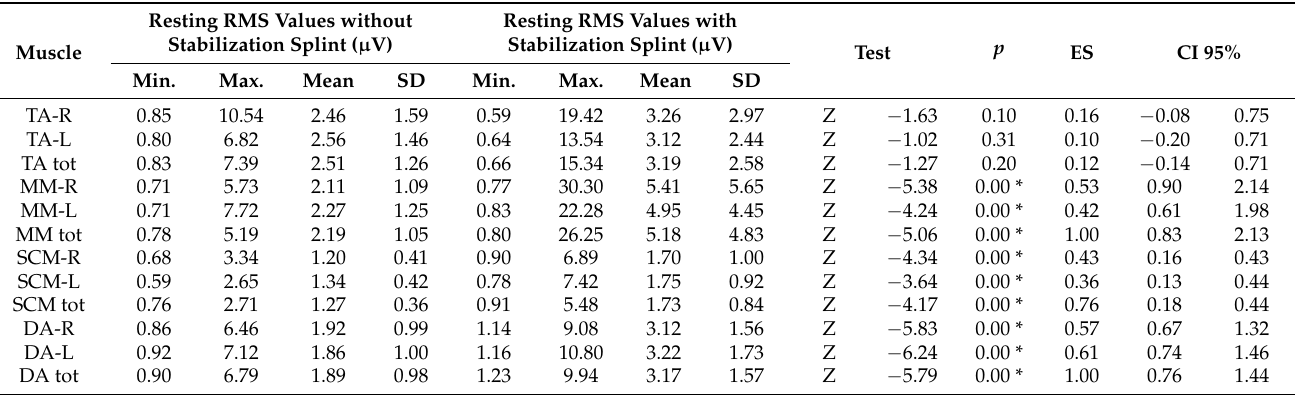
Table 2. Comparison of root mean square (RMS) bioelectric resting potentials with and without stabilization splint.